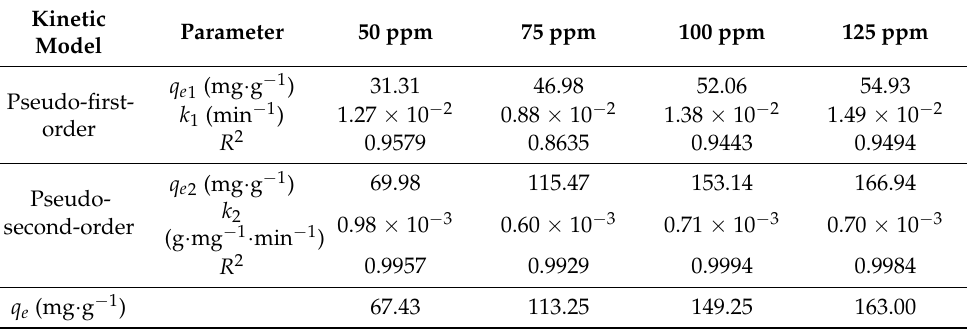
Table 3. Kinetic parameters for adsorption of Cu 2+ onto the rGO membrane. q e (mg · g − 1 ) and q t (mg · g − 1 ) are the amount of Cu 2+ adsorbed on the rGO membrane at equilibrium time and contact time, respectively; k 1 (min − 1 ) and k 2 (g (mg min) − 1 ) are the rate constants of the pseudo-first-order and pseudo-second-order models,